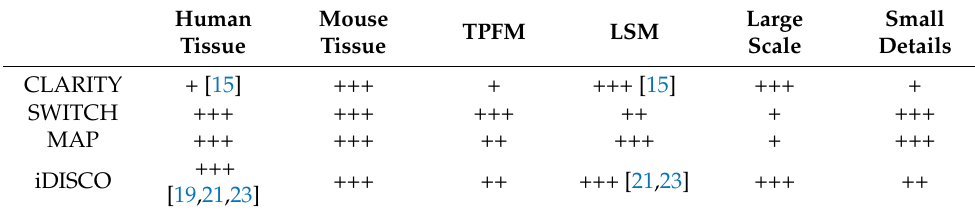
Table 1. Comparison of the different techniques used in this work (+ Fair; ++ Good; +++ Excellent). References are listed for the conditions used in different works (where present, they all confirm our findings). Human Mouse TPFM LSM Tissue Tissue